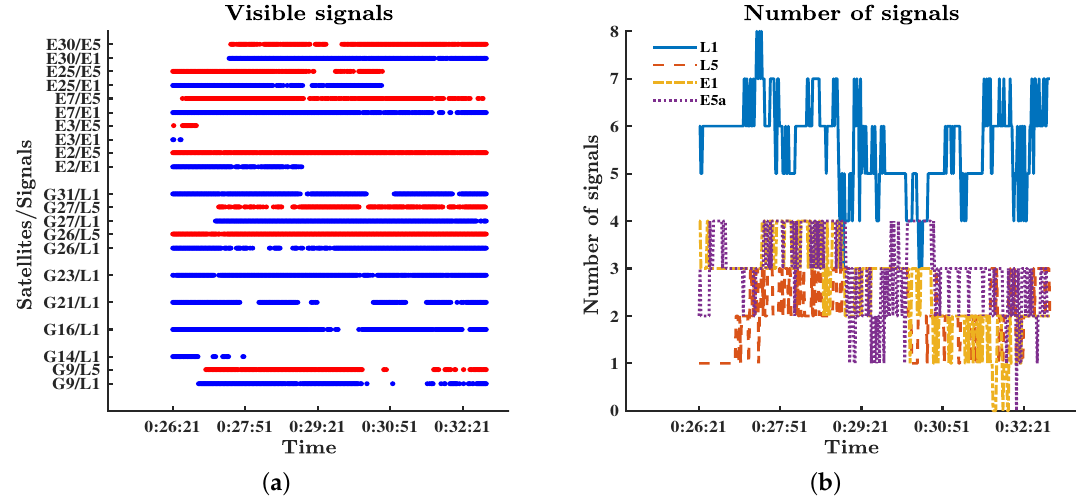
Figure 7. Signals tracked by the Xiaomi Mi 8. ( a ) Visible signals and satellites; ( b ) number of